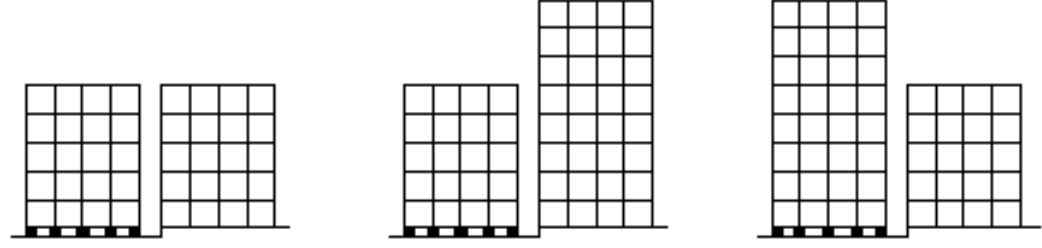
Figure 1. Schematics of 2D structural component models of medium-to-high-rise buildings.